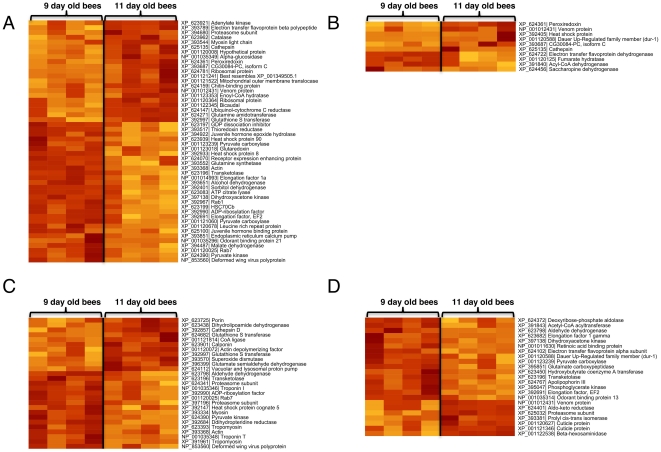
Age-related changes in protein abundance.Heatmaps of proteins that displayed abundance changes associated with age (Mann-Whitney U-test rank sum test, p<0.1, bootstrap corrected cutoff). Rows were clustered using Pearson correlation and complete linkage clustering. Rows represent proteins, columns represent samples. High values are distinguished by a red color, low values are yellow. A: Low pollen hoarding genotype control (CL); B: low pollen hoarding genotype knockdown (KL); C: high pollen hoarding genotype control (CH); D: high pollen hoarding genotype knockdown (KH).